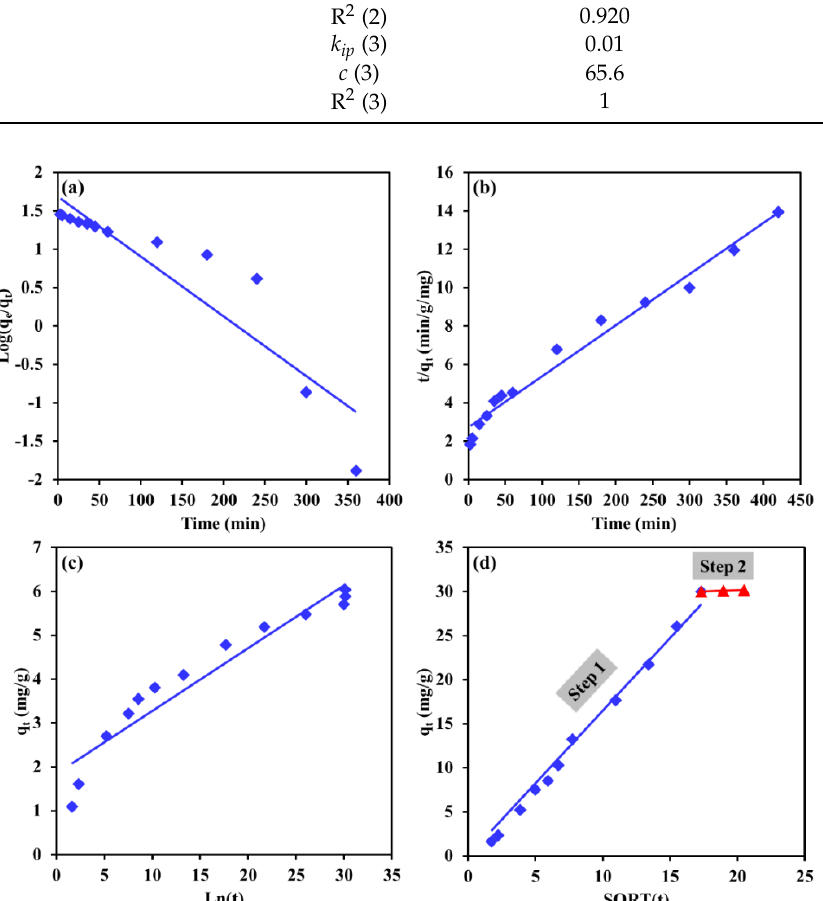
Figure 13. Linearized kinetic models fit of EBT dye removal by Mg − Ca − Al − LDO composite for ( a ) pseudo 1st order, ( b ) pseudo 2nd order, ( c ) Elovich and ( d ) intraparticle diffusion models.